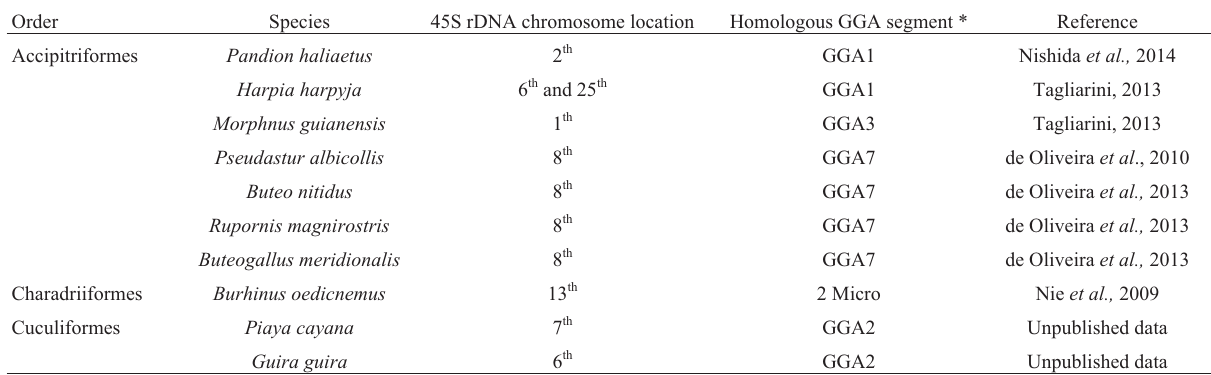
*Homologies established by chromosome painting; Micro: